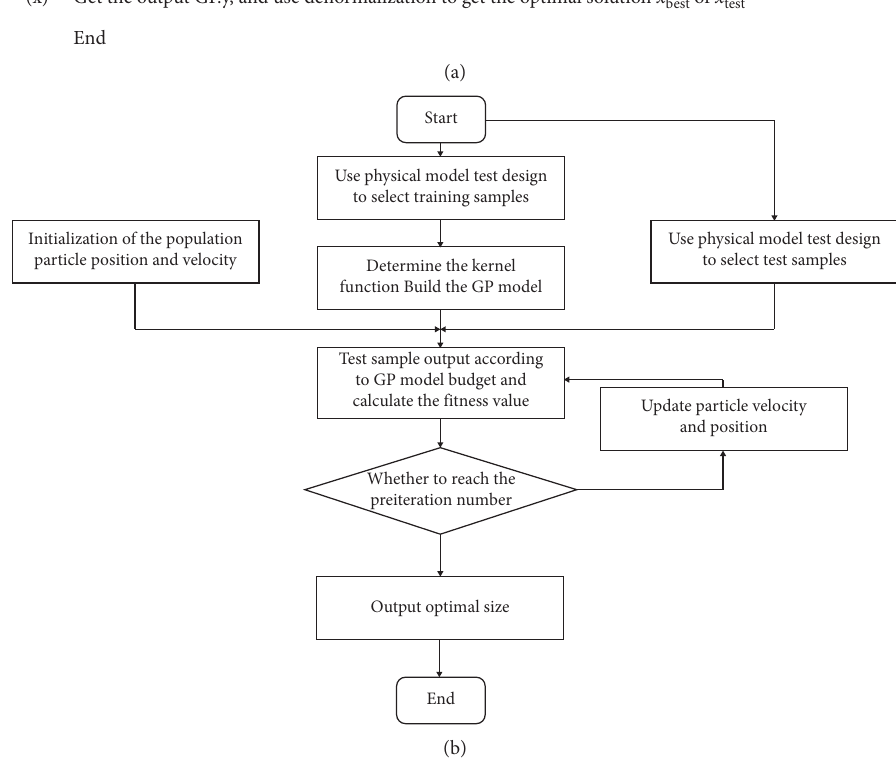
Figure 1: PSO-GP model. (a) PSO-GP pseudo-code. (b) PSO-GP